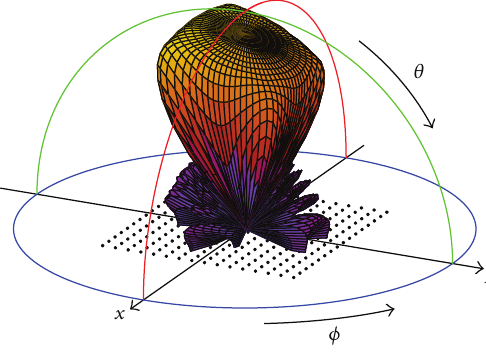
Figure 3: SRA-256 pattern shaped as 𝑆 𝑟𝑦 .